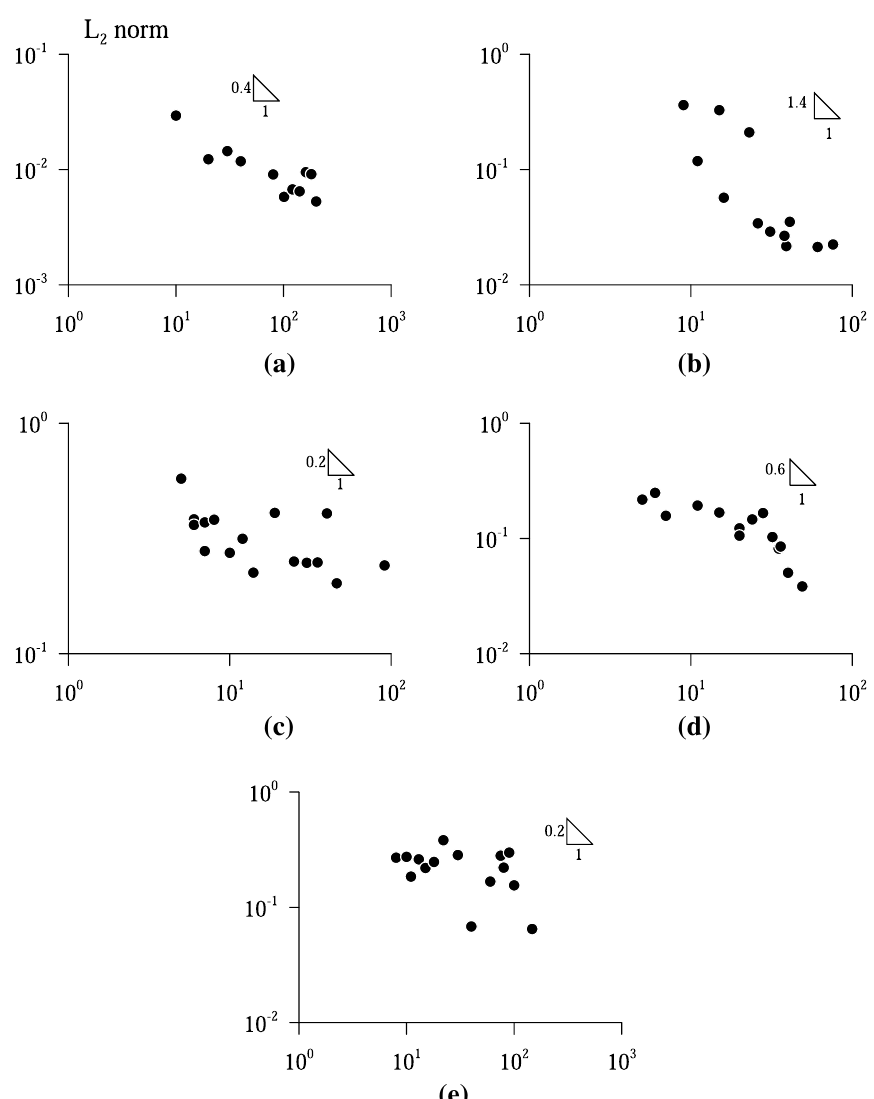
Fig. 9 Rate of convergence. a Case 1, b Case 2, c Case 3, d Case 4, and e Case